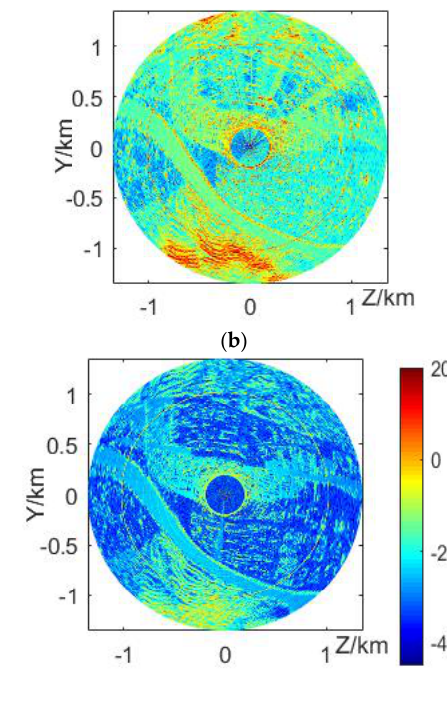
( b ) Figure 6. The comparison of range profiles at different azimuth angles between 3D PE in ( a ) and 2D PE model in ( b ) under the same conditions as the above and radar erection heights is 500 m. The target is marked by a red box. 5. Conclusions This paper verifies and develops the ground clutter simulation method based on PE to predict the ground clutter when the terrain data are known. The proposed method can intuitively predict the coverage of radar detection airspace and the strong ground clutter area, meet the needs of strong clutter area prediction under known terrain conditions, and provide a theoretical basis for radar location and optimal deployment.